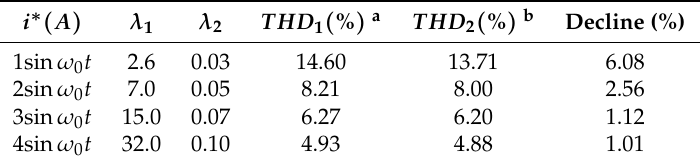
Table 4. THD in different current.